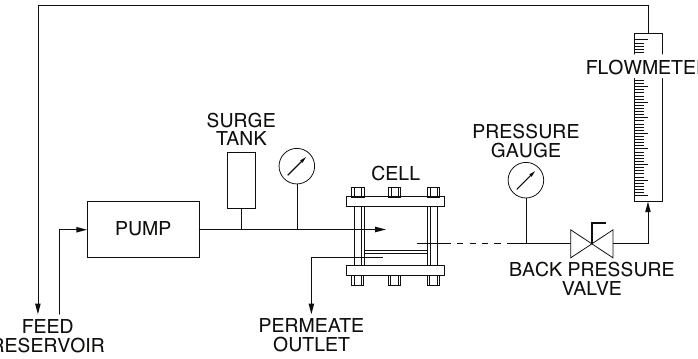
Figure 1. Flow diagram of the UF